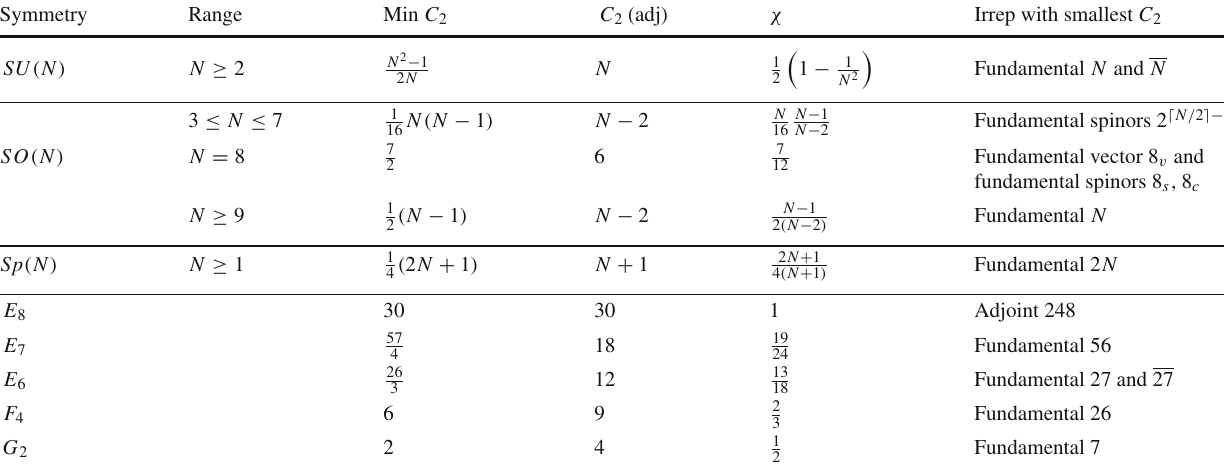
imum. We notice that for D 4 , corresponding to SO ( 8 ) , the Dynkin dia- gram has a three-fold symmetry leading to triality amongst the smallest Casimir operators in the fundamental vector and spinor representations